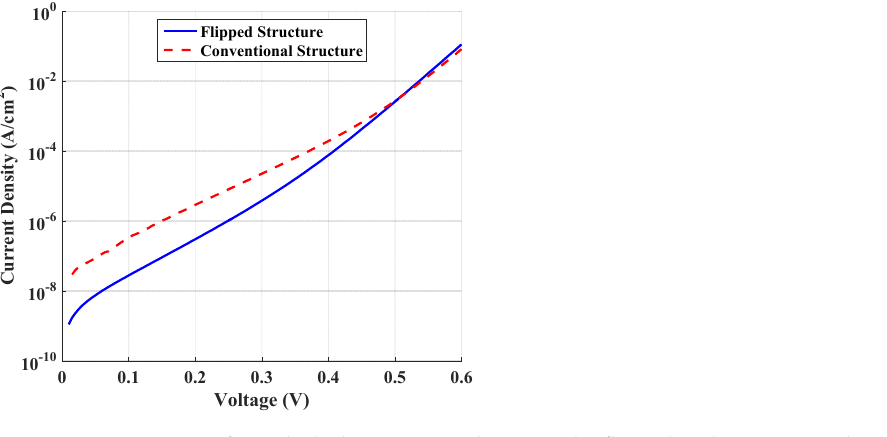
Figure 4. Comparison of J-V dark characteristics between the flipped and conventional structures. Table 2. Main parameters for dark characteristics for the conventional and the flipped microstructures. The analytical and TCAD values of the V oc are also listed.